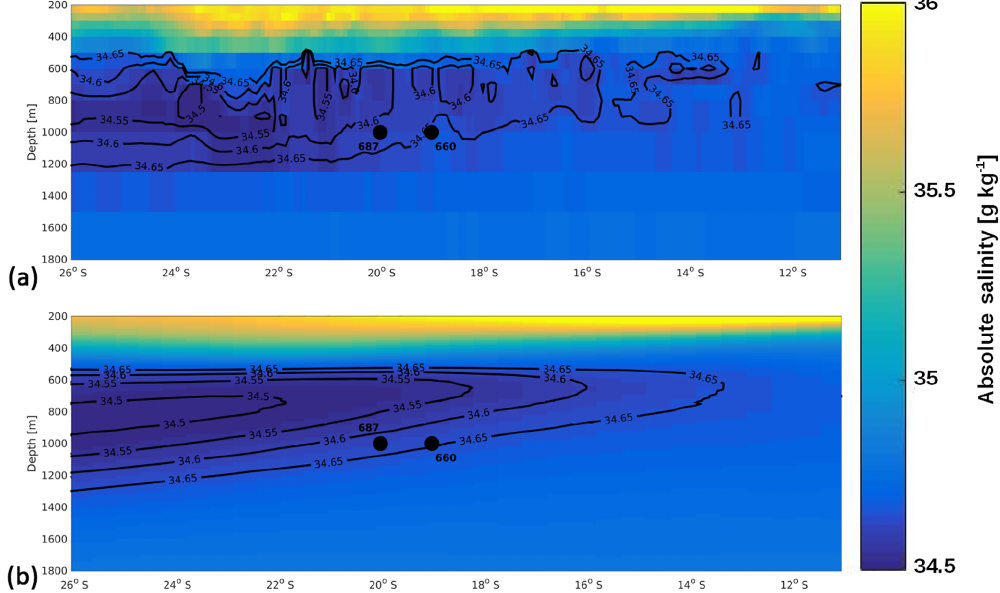
Figure 9. Absolute salinity meridional section at 157 ◦ W calculated from (a) the HYCOM re-analysis on 13 November 2015 and (b) the ISAS13 atlas for November seasonal climatology. Black dots indicate the mean location of the floats.